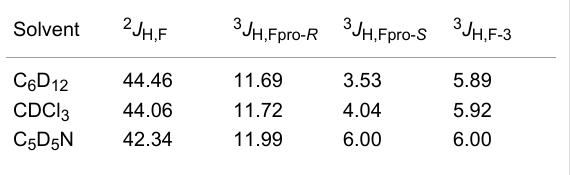
rium in 1 . Some more polar solvents, e.g., MeCN and DMSO, were found to convert Ishikawa´s reagent into an amide; there- fore, they were not further studied. Table 1: Experimental coupling constants (Hz) for 1 . Solvent